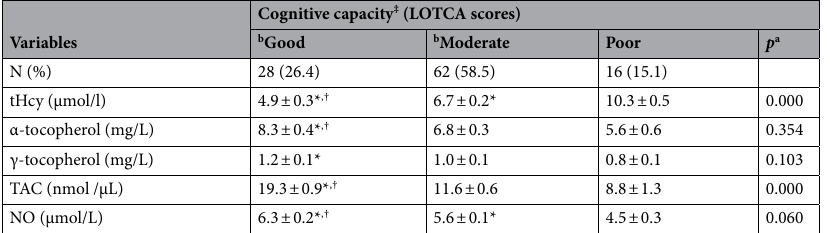
Table 3. Associations between biomarkers (total homocysteine, α-tocopherol, γ-tocopherol, and oxidative stress markers) and cognitive capacity in older adults (n = 106). Values are expressed as mean ± SE (adjusted scores). TAC, total antioxidant capacity (nmol/μL); tHcy, total homocysteine levels (μmol/L); NO, nitric oxide; LOTCA, Loewenstein Occupational Therapy Cognitive Assessment. *Significant difference between Good or Moderate and Poor cognitive capacity. † Significant difference between Good and Moderate cognitive capacity. ‡ Age, sex, educational level, and sex were used as a covariate a Analysis of covariance (ANCOVA). b Adjustment for multiple comparisons